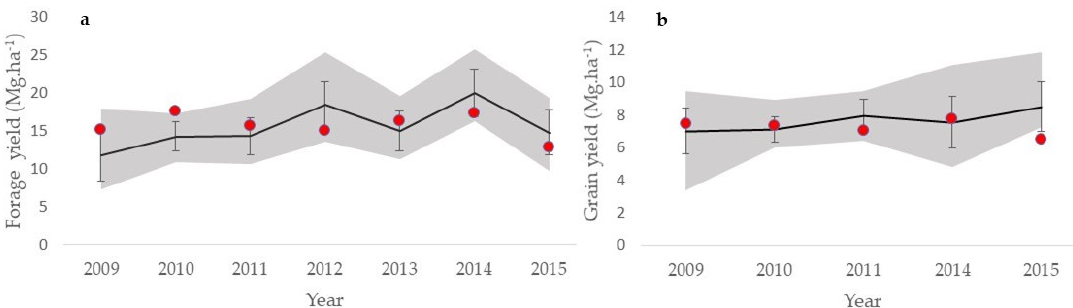
Figure 2. Average of 19 years of measured (black line) and simulated (red points) yields of ( a ) forage and ( b ) grain sorghum. Gray area represents the range of measured yields, and bars represent standard deviation considering all the hybrids evaluated.